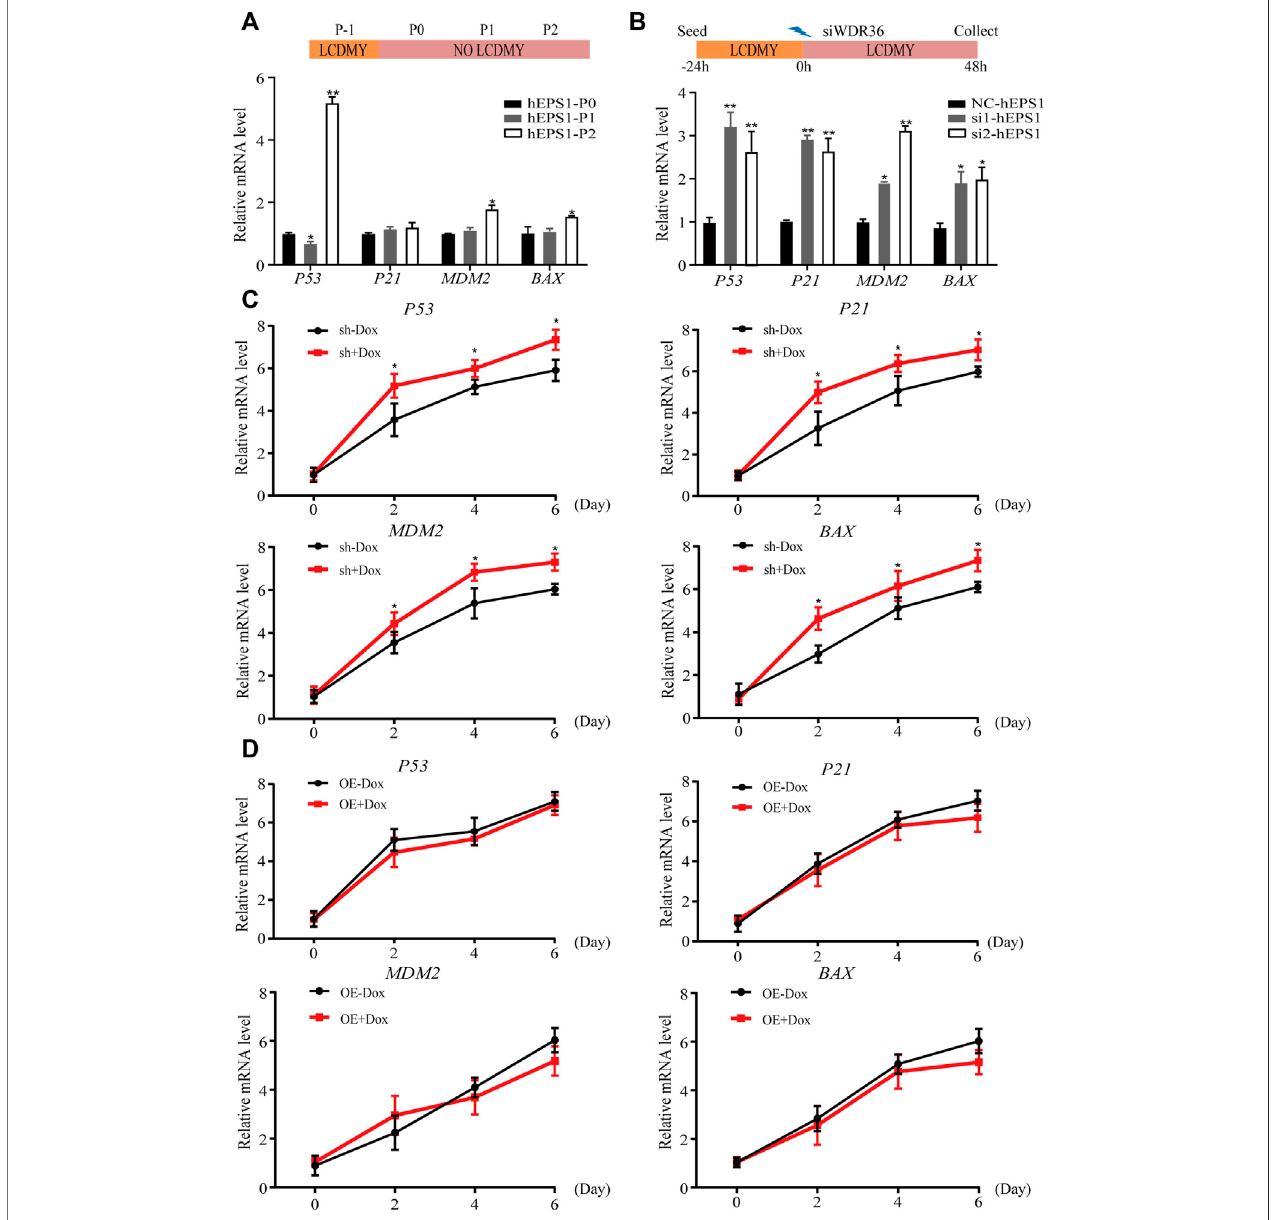
FIGURE 5 | Expression of P53 pathway-related genes during the spontaneous differentiation procedure of hEPS1 cells. (A) Expression of P53 , P21 , MDM2 , and BAX in hEPS1 cells which were cultured in the N2B27 medium at P0, P1, and P2. (B) Expression of P53 , P21 , MDM2 , and BAX in hEPS1 cells with WDR36 siRNA. NC: siRNA-scramble; si1: small interference RNA 1 of WDR36; si2: small interference RNA 2 of WDR36. (C) Expressions of P53 , P21 , MDM2 , and BAX in Dox-induced WDR36 knockdown EBs treated with or without Dox. (D) Expressions of P53 , P21 , MDM2 , and BAX in Dox-induced WDR36 overexpression EBs treated with or without Dox. OE: overexpression of WDR36. n = 3 experiments; mean ± S. D; two-tailed Student ’ s t-test. *, 0.01 < p < 0.05; **, p < 0.01; no labeling indicates no statistical signi fi cance.